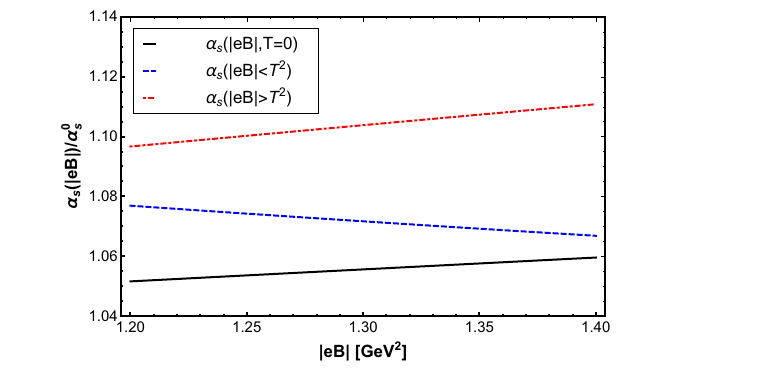
Figure 1. (Color on line) Strong coupling running as a function of the magnetic field strength. The curves are computed using a fixed transferred momentum Q 2 = 1 GeV 2 . The black solid line shows the case for T = 0. The blue dash line shows the case when | eB | < T 2 computed with T = (cid:101) T = 1 . 5 GeV. The red dash-dot line is the case for | eB | > T 2 computed with T = 1 . 1 GeV and | (cid:102) eB | = 1 . 2 GeV 2